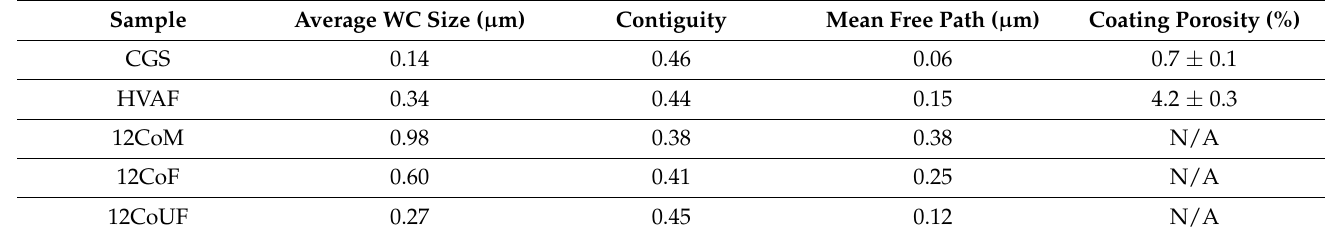
Figure 5. Microstructure of the bulk ( a ) 12CoM, ( b ) 12CoF and ( c ) 12CoUF samples. Table 2. Microstructural parameters of the examined samples.